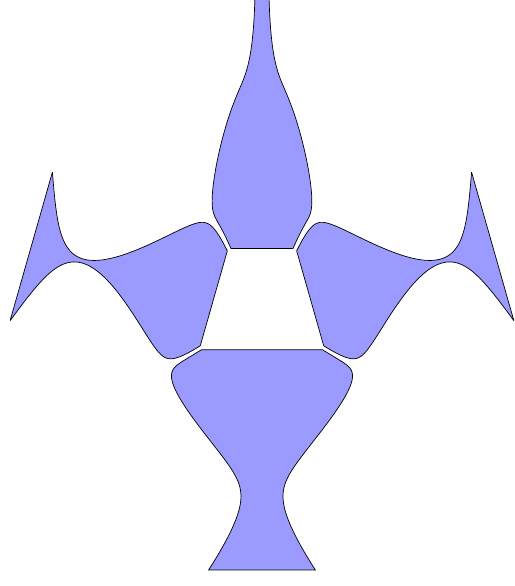
Figure 22. The developed developable surfaces created using method